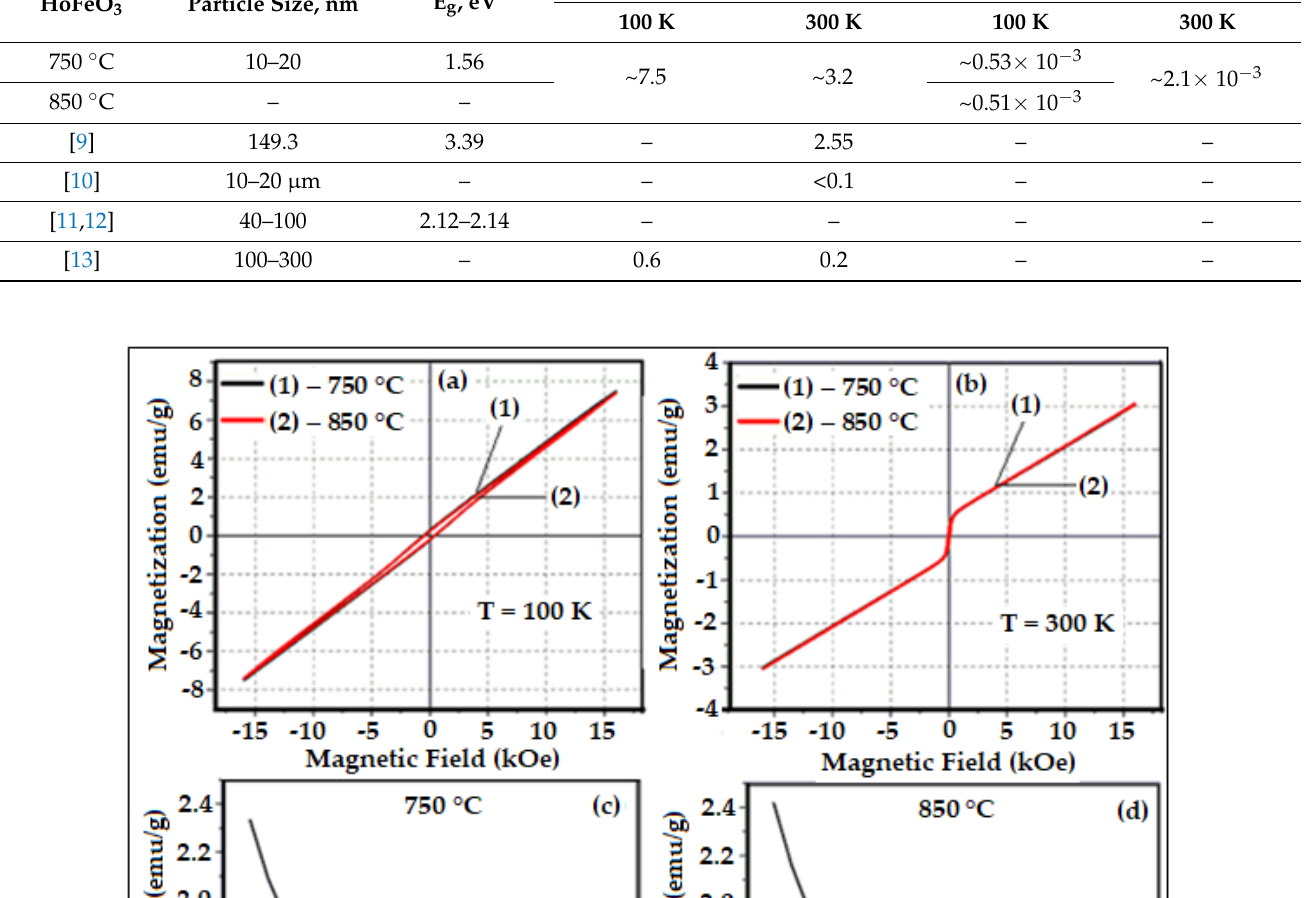
Table 1. Characteristics of HoFeO 3 nanoparticles in this work and that from the published literatures as a comparison. HoFeO 3